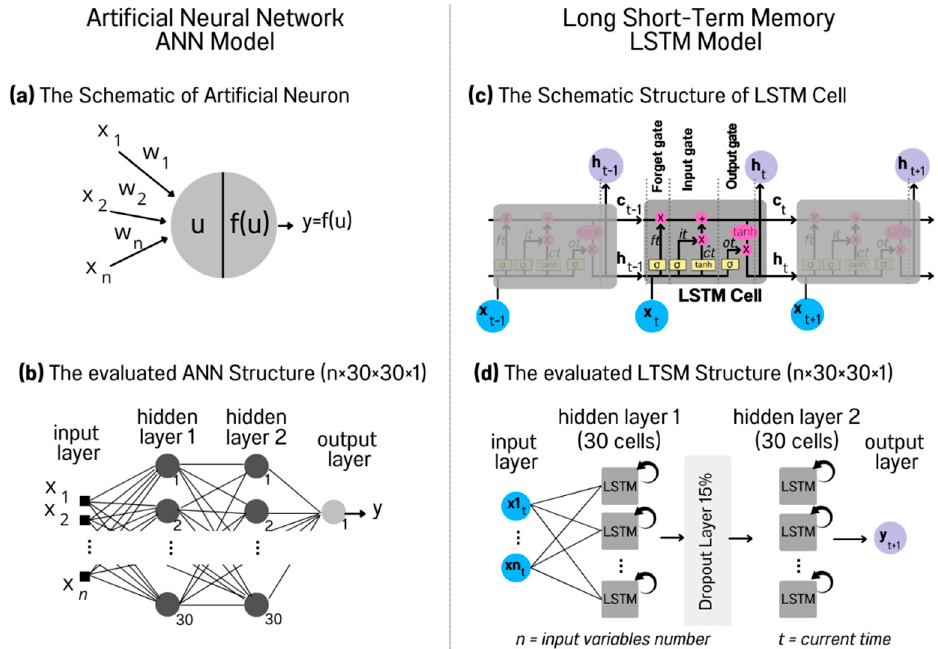
Figure 6. ANN Model: ( a ) an artificial neuron and ( b ) the ANN structure. LSTM model: ( c ) the LSTM cell structure and ( d ) the LSTM structure (the temporal recurrent structure is not shown).